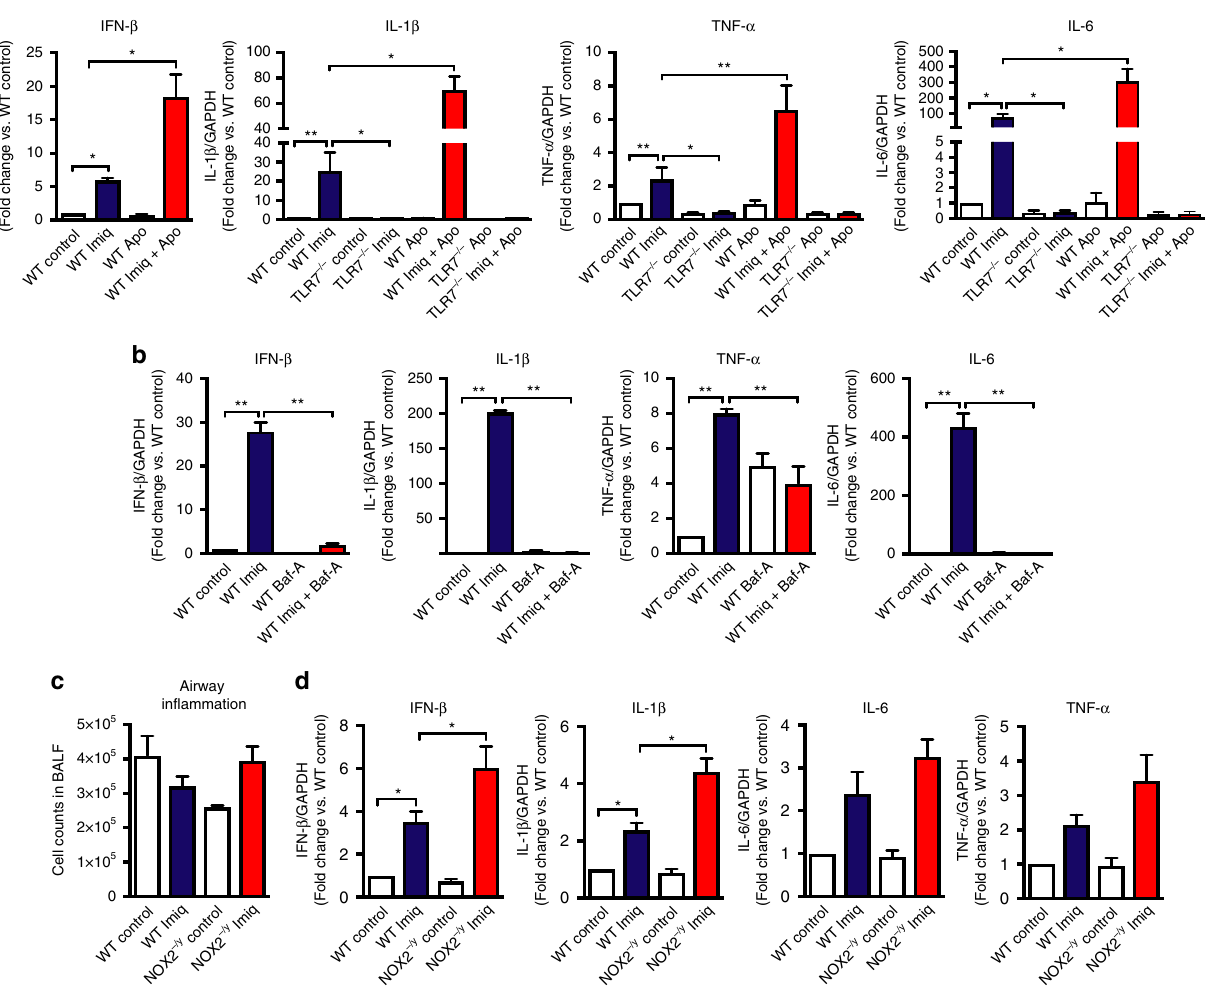
Fig. 5 Endosomal NOX2 oxidase suppresses cytokine expression in response to TLR7 activation in vitro and in vivo. a , b WT and TLR7 − / − immortalized bone marrow-derived macrophages (BMDMs) were untreated or treated with imiquimod (Imiq; 10 μ g/ml) in the absence or presence of a